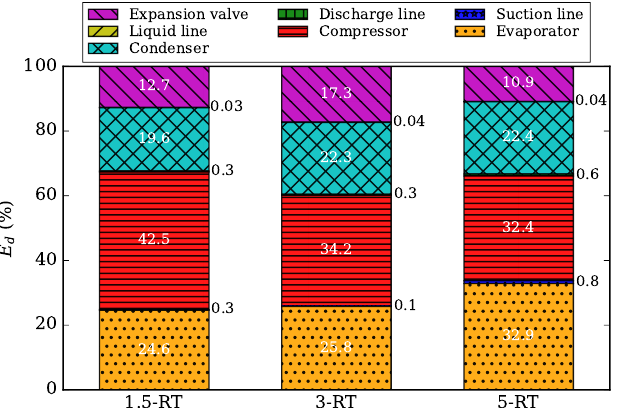
Figure 10. Exergy destruction (or irreversibility) ratio comparison for the components of 1.5-RT, 3-RT, and 5-RT ECUs at Test Condition